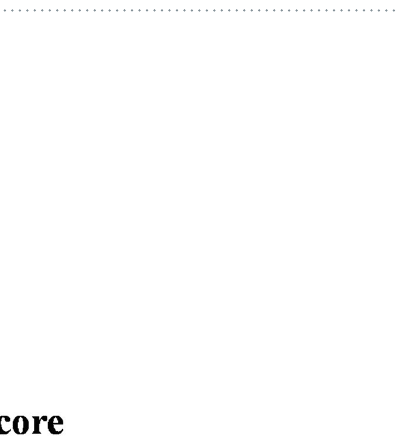
Figure 8. Schematic of the combustion of a nanoparticle coated with a thin oxidizer.